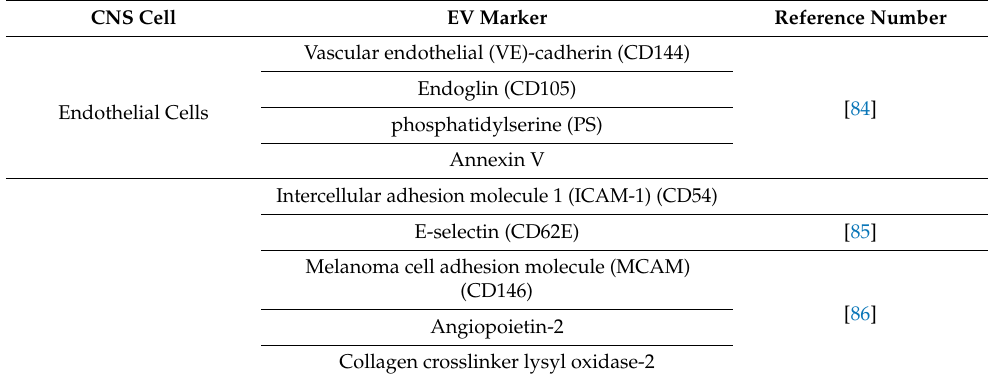
Table 1. CNS cell types and EV markers. Table summarizing CNS cell types and their respective markers commonly used to assess EV cell